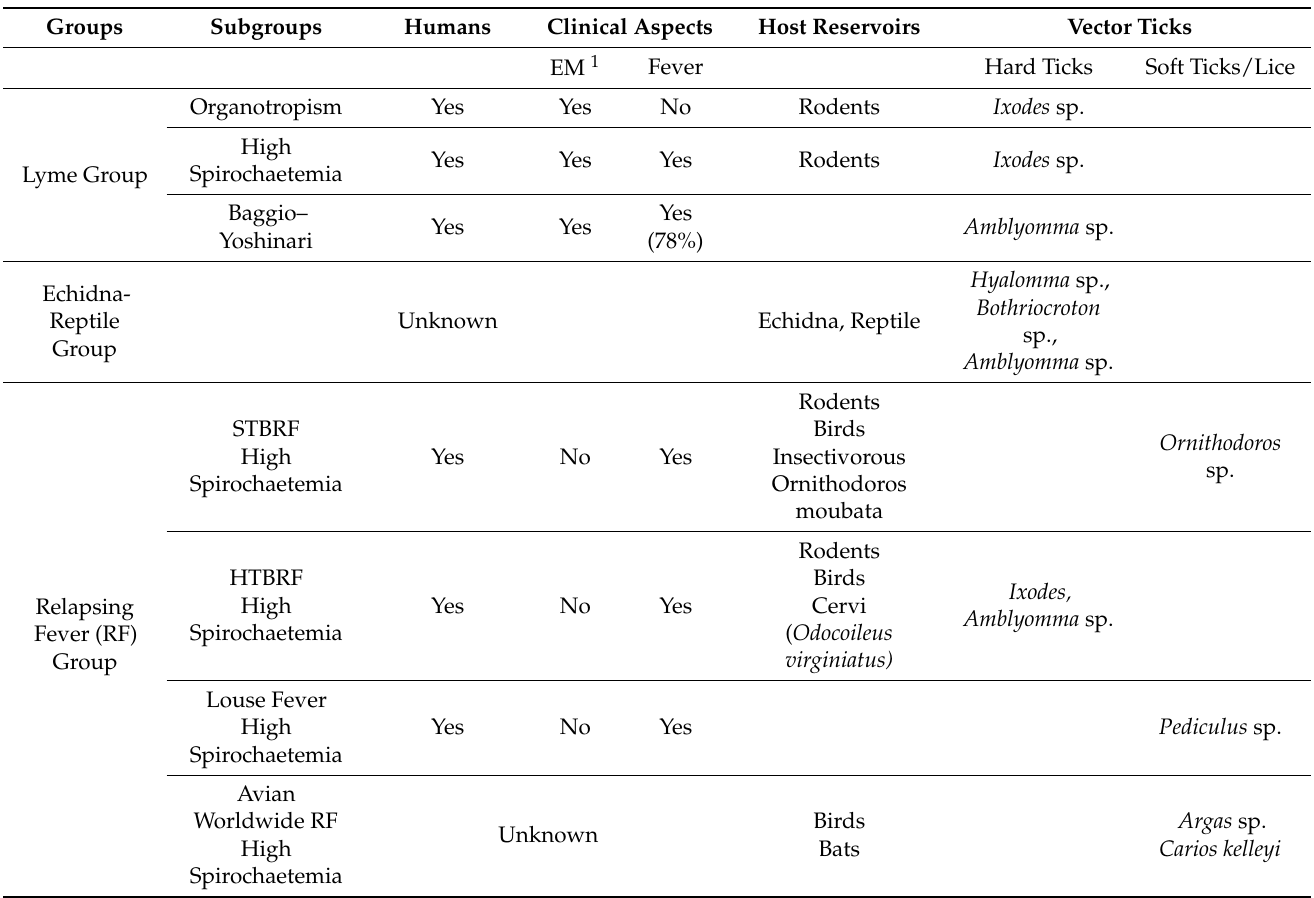
Table 3. Borreliae classification into three main